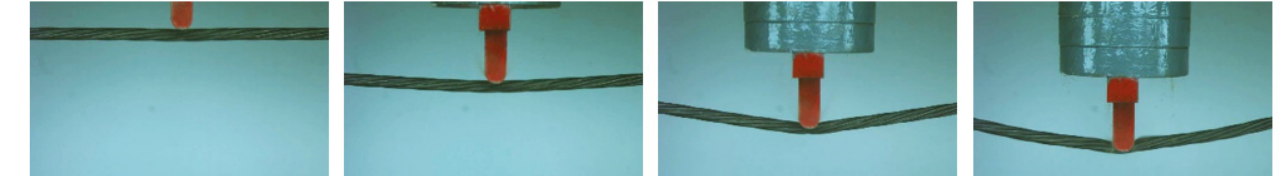
Figure 10. Photographs of impact zone for the working condition of µ p = 0.298 and V 0 = 12.55 m/s